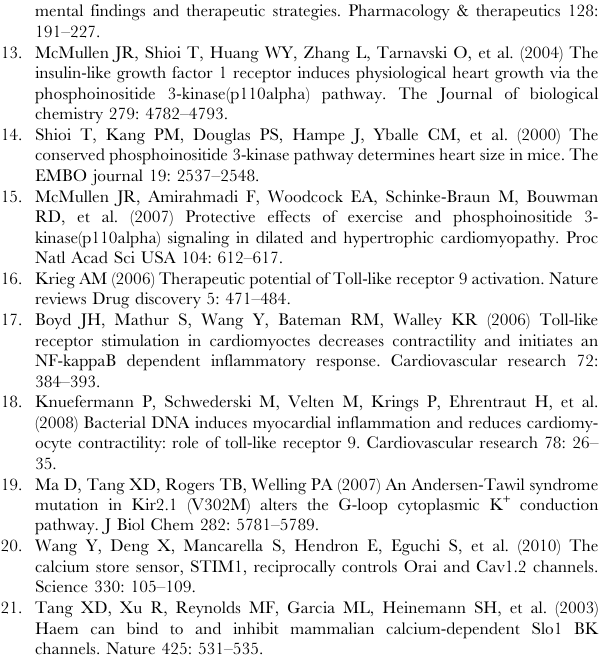
Figure S1 Isoproterenol-induced fetal gene expression was blunted by CpG ODN 1585, C274 but not CpG ODN 1826 or other TLR agonists in neonatal myocytes. (A, B) induction of ANF (A) and b -MHC (B) mRNAs by isoproterenol as measured by qPCR assays and its blockade by pre-treatment with CpG ODN 1585 or C274. Neonatal myocytes were pre-treated with PGN (10 m g/ml, TLR2 agonist), PolyI:C(25 m g/ml, TLR3 agonist), LPS (1 m g/ml, TLR4 agonist) or CpG ODN 1585, 1826 or C274 (5 m g/ml, TLR9 agonist) for 12 h followed by ISO stimulation for 48 h. 18-S rRNA was used as an internal standard. The mean normalized value for expression of each gene in unstimulated cells is defined as